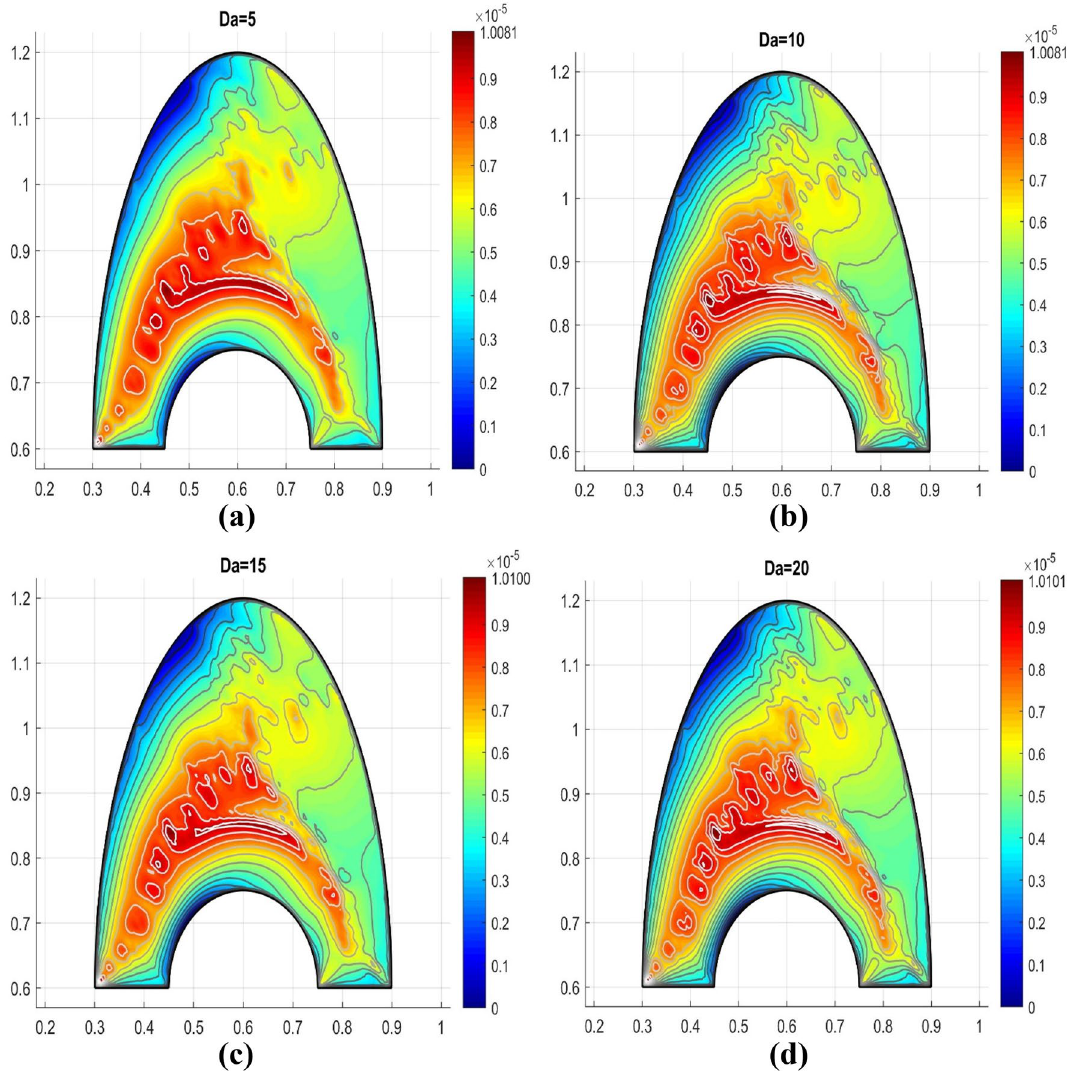
Figure 7. Variable porosity parameter for the porosity factor.